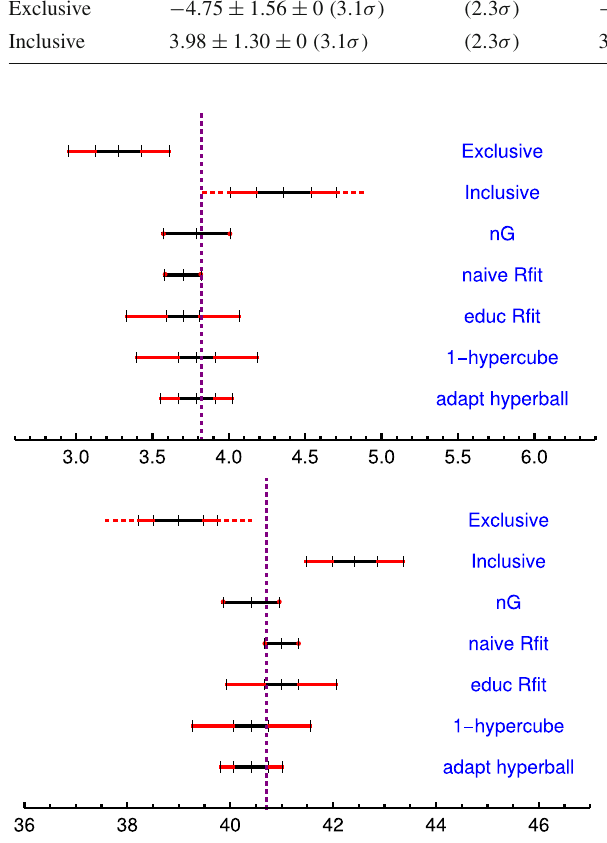
Fig. 9 Top inclusive and exclusive inputs for the CKM matrix element | V | (times 10 3 ) and the averages resulting from the different models ub considered here. Bottom same for the determinations of | V cb | (times 10 3 ) CKM matrix element. The intervals are given at 1 σ . See Fig. 7 for the